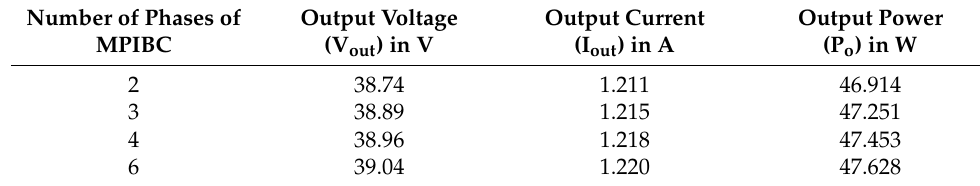
Table 5. Output parameter values of MPIBC (input voltage: 20 V).